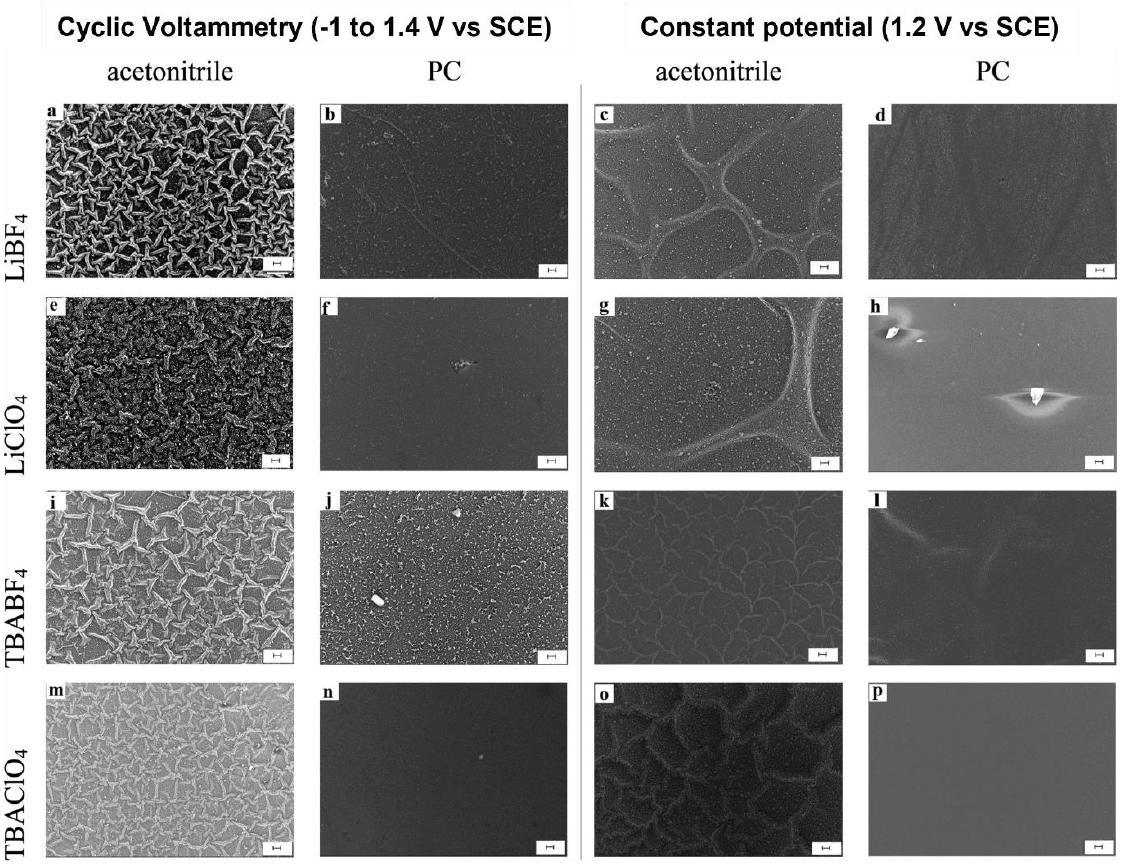
Figure 2. SEM images of PEDOT films obtained on ITO electrodes for different synthesis conditions (scale bar is 10 μm). Reprinted with permission from [39]. Copyright 2010 American Chemical Society.